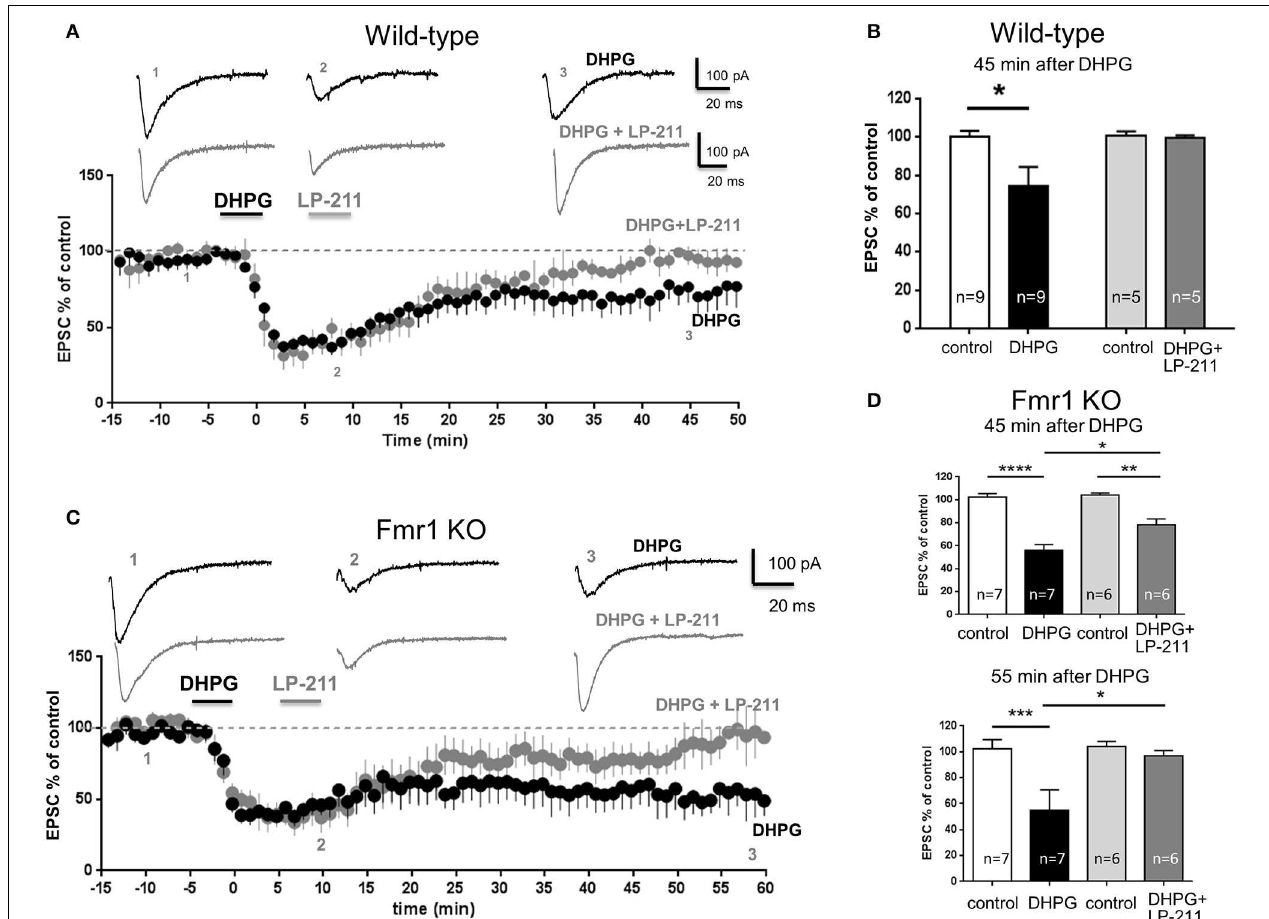
FIGURE 2 | LP-211 reversed mGluR-LTD in the hippocampus of wild-type and Fmr1 KO mice. Excitatory post-synaptic currents (EPSCs) mediated by AMPA receptors were recorded under whole-cell patch clamp from CA1 pyramidal neurons after stimulation of Schaffer collaterals in the continuous presence of the NMDA receptor antagonist D-AP5 (50 µ M). EPSC amplitude is represented as percent of control EPSC amplitude